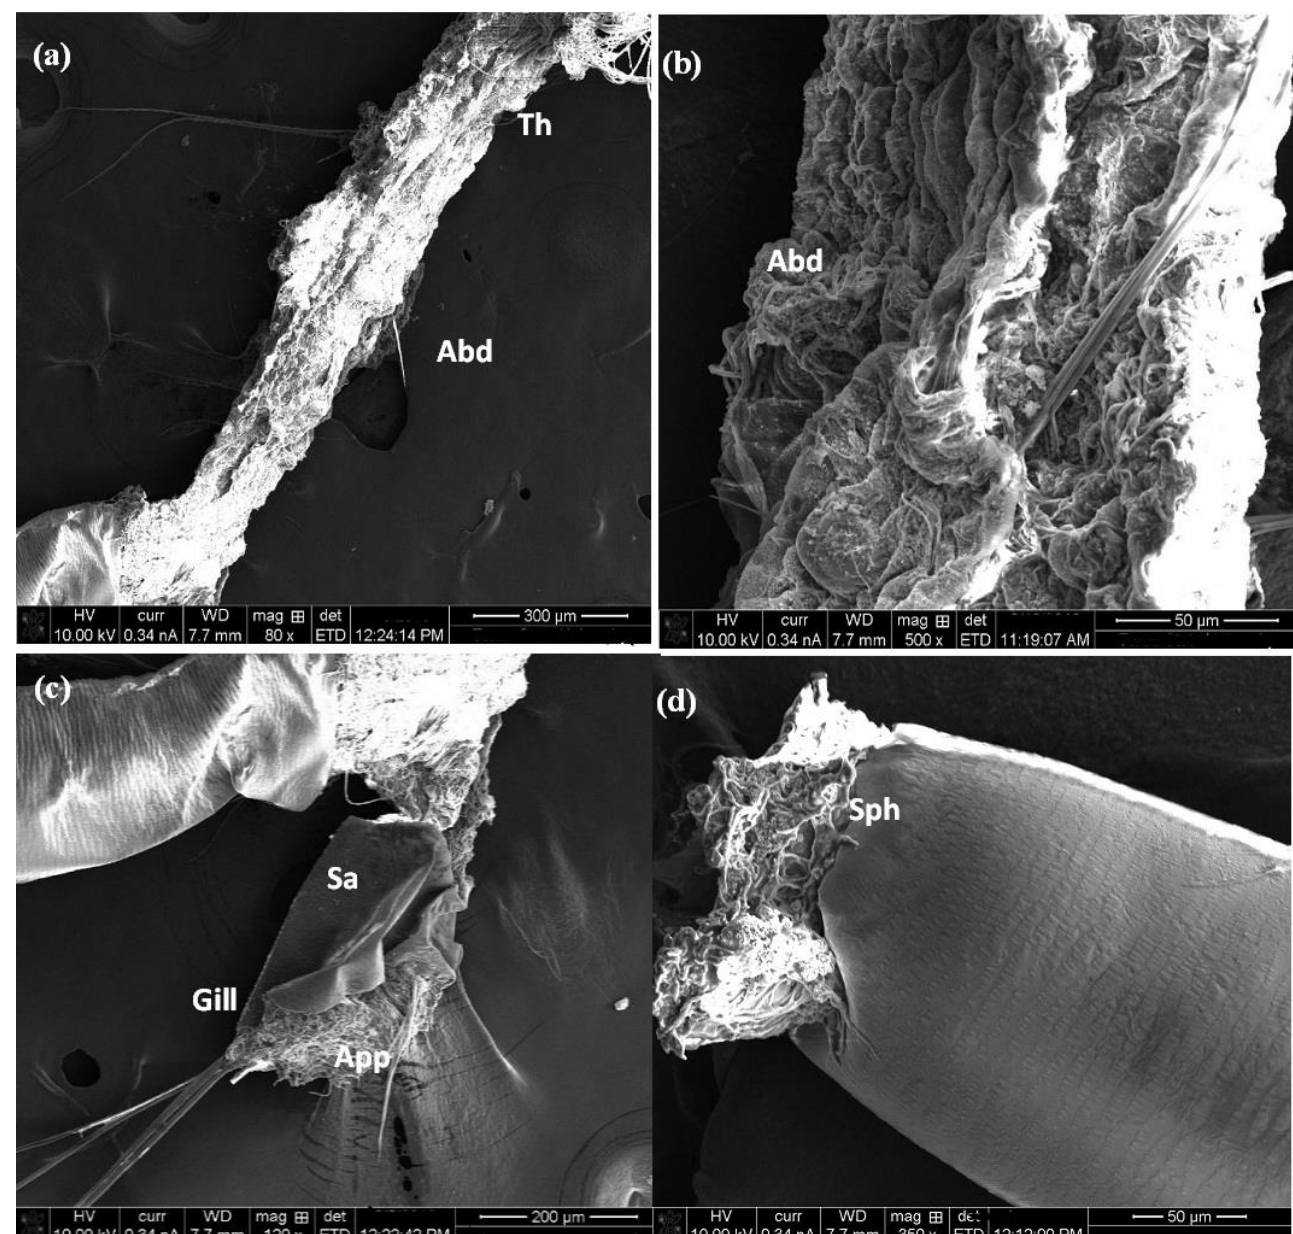
Figure 8. SEM of C. pipiens (body parts) exposed to Co 3 O 4 NPs. ( a , b ) show that Co 3 O 4 adheres to the abdominal cuticle. ( c , d ) demonstrate the NPs in the respiratory siphon and gills. (Abd: Abdomen, Cu: cuticle, G: gill, Sa: saddle, Siph; siphon).